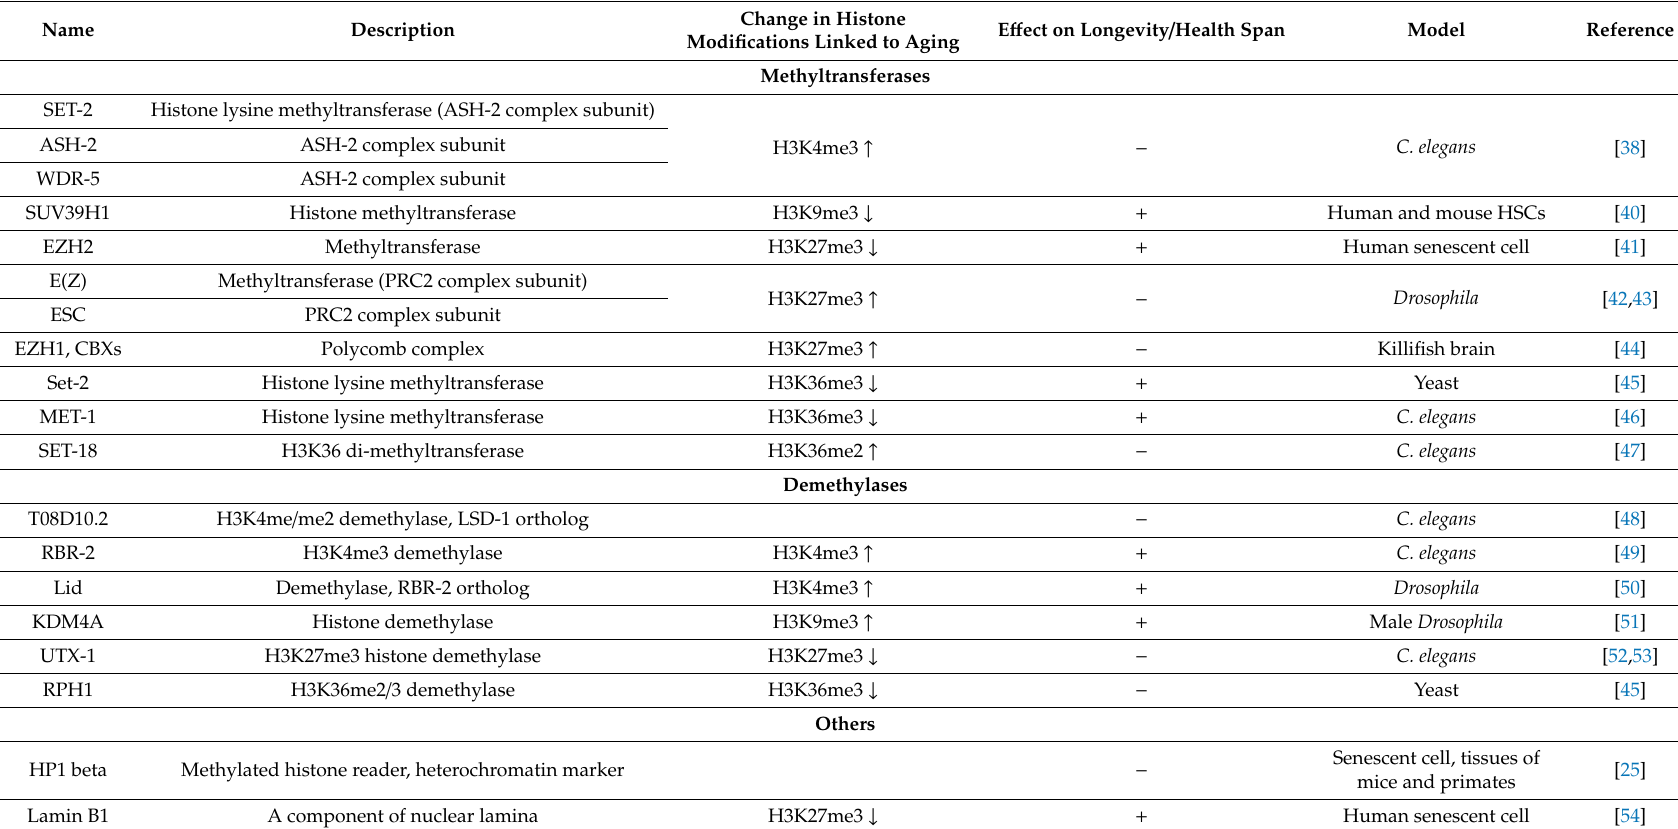
Table 2. Histone methylation-modulating proteins and